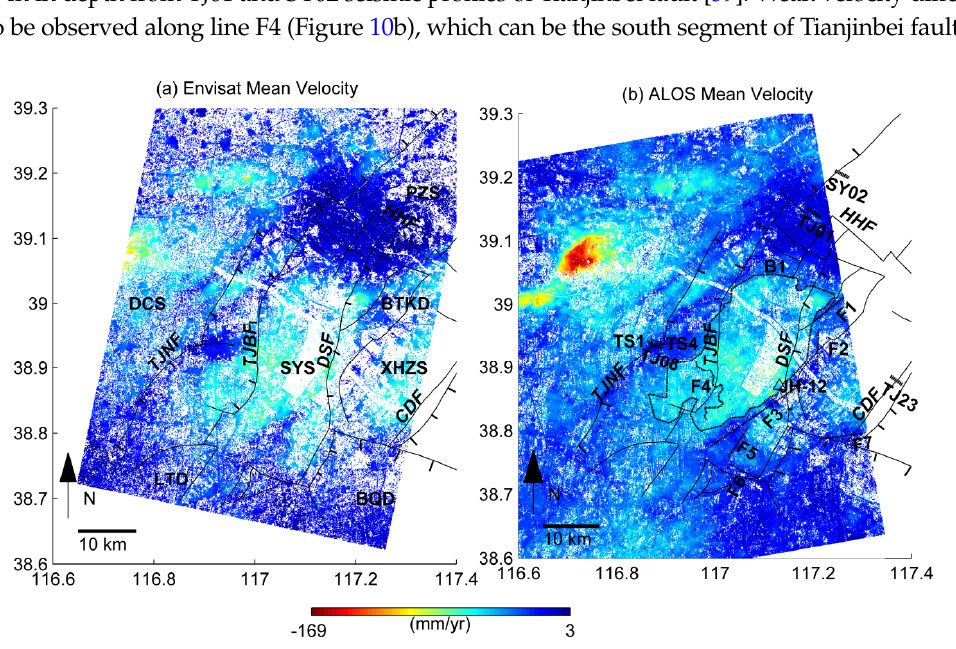
Figure 10. Faults and LOS subsidence rates in Tianjin: ( a ) Tectonic system of the area includes Dacheng Salient (DCS), Shuangyao Salient (SYS), Panzhuang Salient (PZS), Xiaohanzhuang Salient (XHZS), Litan Depression (LTD), Banqiao Depression (BQD), and Baitangkou Depression (BTKD) [57–59,61,62]. Major faults include the Tianjinnan Fault (TJNF), Tianjinbei Fault (TJBF), Dasi Fault (DSF), Haihe Fault (HHF) and Cangdong Fault (CDF); ( b ) TJ01 and SY02 are seismic profile of TJBF. TJ08 is seismic profile of TJNF, and TS1 and TS4 are boreholes near TJ08. TJ23 is seismic profile of CDF